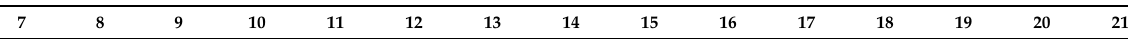
Table 4. Correlation matrix between latent variables on the validation